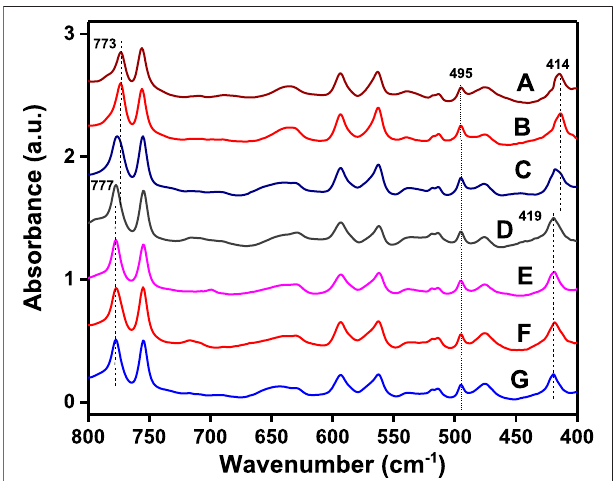
FIGURE 2 | FTIR spectra of PPO fi lms as obtained by solution casting, followed by guest extraction by acetonitrile: A) p -xylene, B) 1,3-